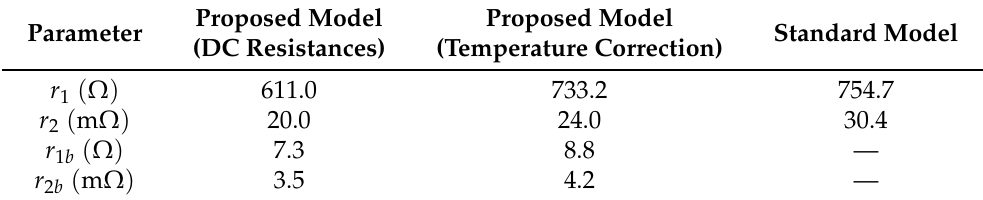
1 ( δ o + δ o ) = 0.012 is highlighted, l h 2 (cid:98) (cid:99) o and was 1.24 ms. δ I δ I